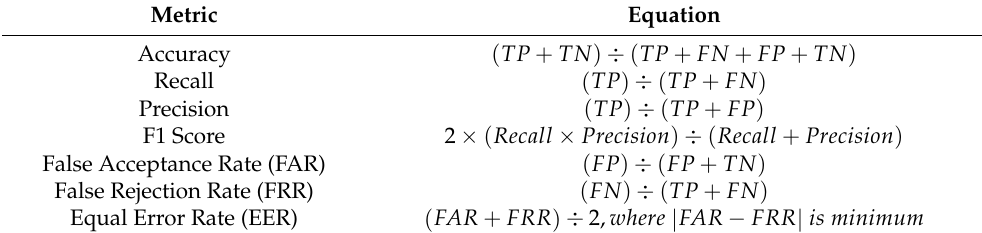
Figure 6. Confusion Matrix. Table 1. Performance